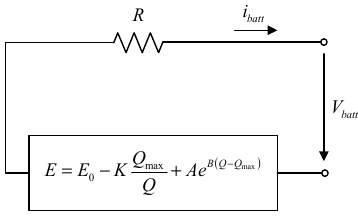
Figure 10. Battery equivalent circuit.